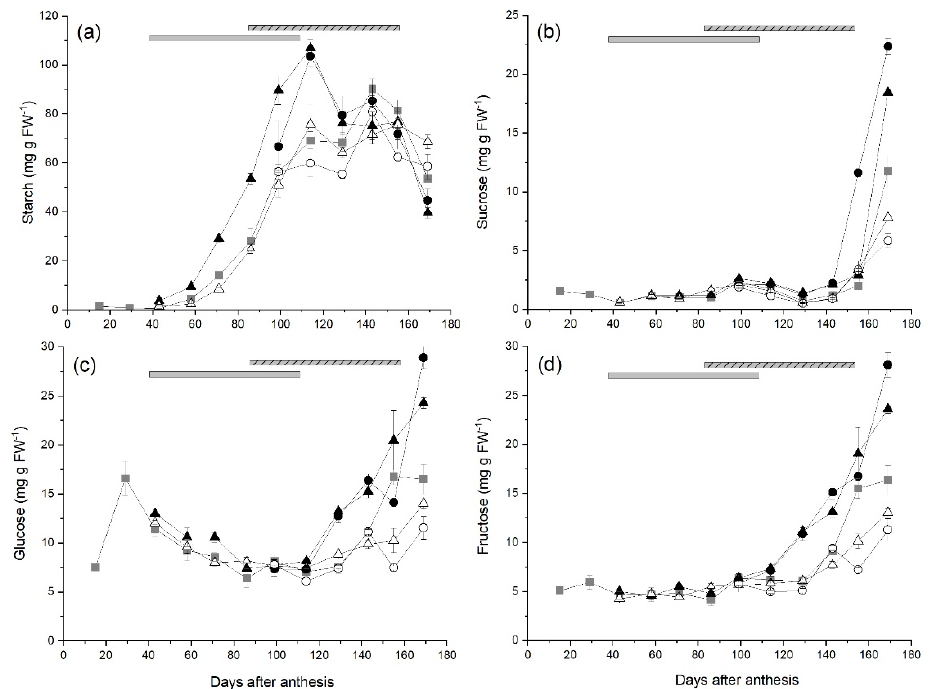
Figure 2. The effect of time of manipulation of carbohydrate supply together with phloem girdling on ( a ) starch ( b ) sucrose ( c ) glucose and ( d ) fructose concentration of Actinidia chinensis var. chinensis ‘Zesy002’, kiwifruit from anthesis through to harvest. Data are shown for ungirdled control canes ( (cid:4) ), early girdled canes with high ( (cid:78) ) or low ( (cid:52) ) carbohydrate supply or late girdled canes with high ( • ) or low ( ) carbohydrate supply. Early treatments were applied at 38 days after anthesis with the duration of the open girdle shown by the grey solid bar at the top of each panel. Late treatments were applied at 86 days after anthesis with the duration of the open girdle shown by the grey/black stripped bar at the top of each panel. High carbohydrate supply treatments had six leaves per fruit, while low carbohydrate supply treatments had one or two leaves per fruit. Data are means ± SEM, n = 5.